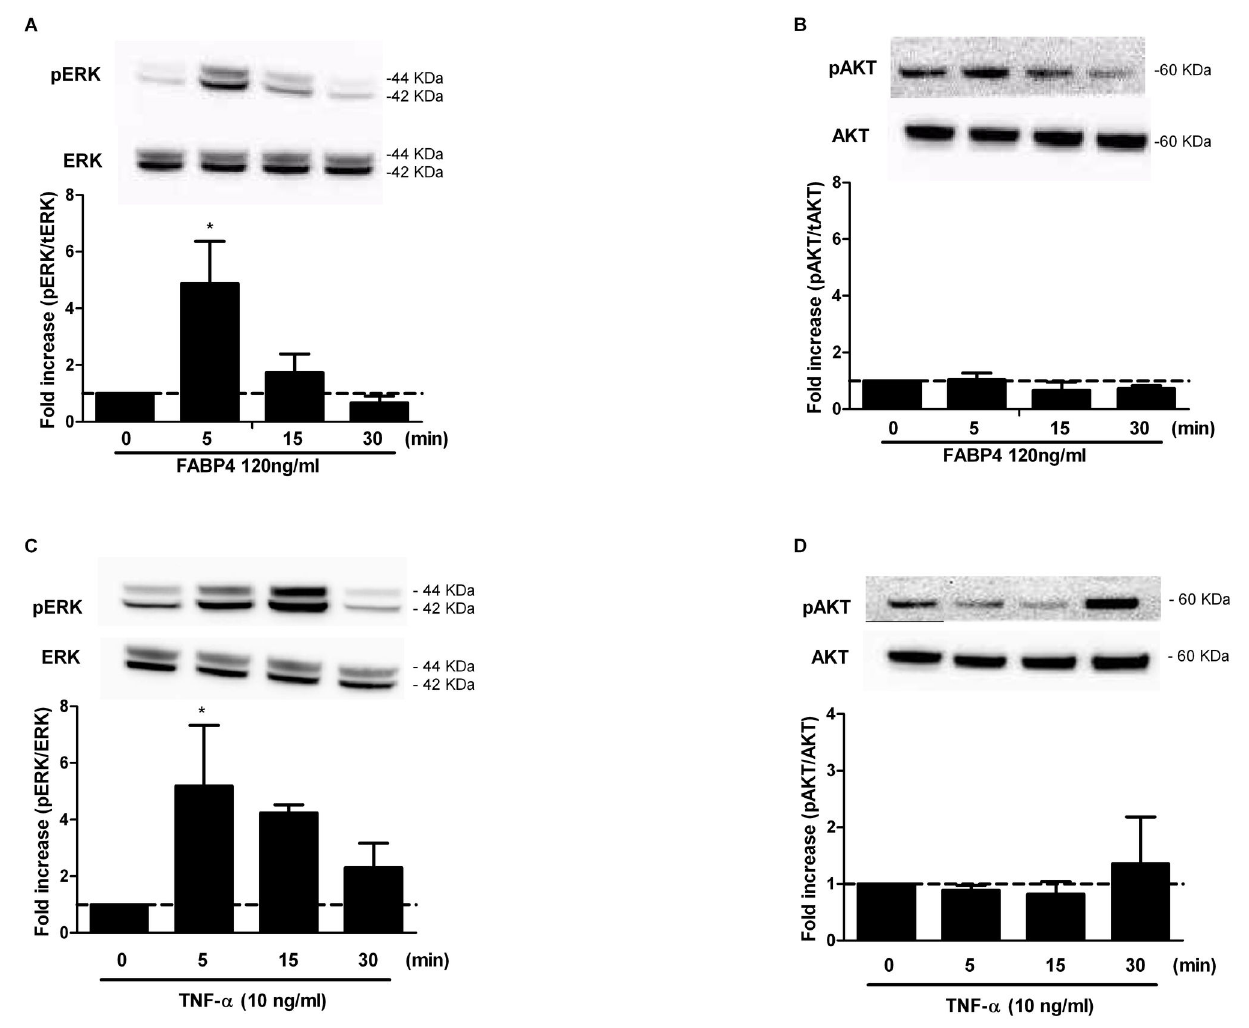
Figure 3. Effect of FABP4 (120 ng/ml) on ERK1/2 and AKT activation in HCASMCs. Effect of FABP4 (120 ng/ml) on ERK1/2 (A) and AKT (B) activation in HCASMCs. TNF-α (10 ng/ml) was used as the positive control (C, D). Representative western blots and relative densitometric analyses are shown. The results are expressed as the mean ± SEM of three separate experiments. *p<0.05 vs. unstimulated cells